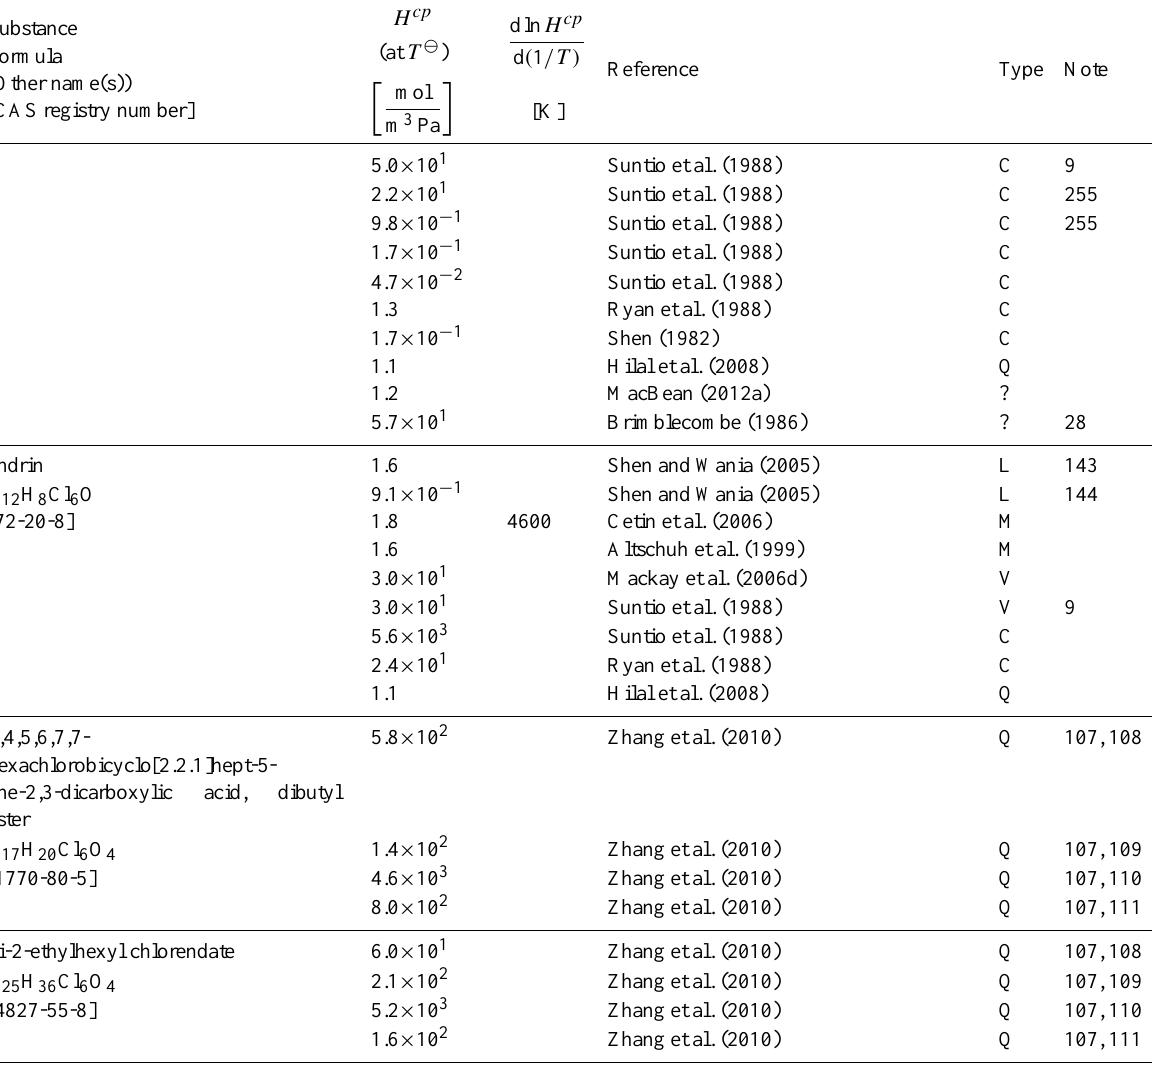
Table 6: Henry’s law constants for water as solvent